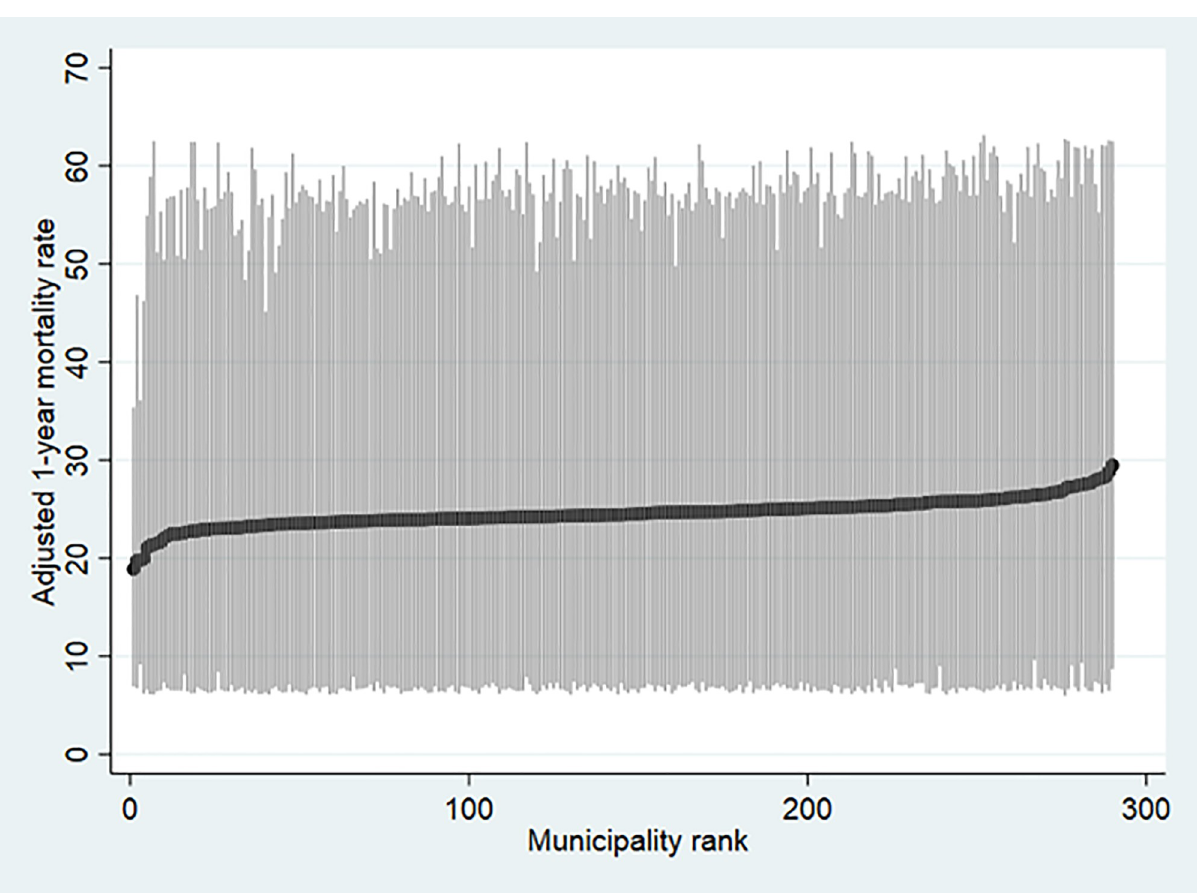
Fig 3. League table ranking the 290 municipalities according to their adjusted absolute risk of 1-year mortality with 95% confidence intervals obtained from the cross-classified multilevel model.